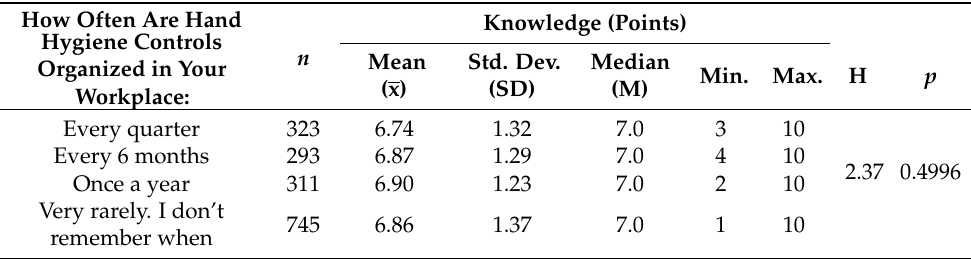
Table 9. Descriptive statistics on the level of knowledge among the respondents with varying frequency of controls on the hand hygiene procedure implementation and the Kruskal–Wallis test results